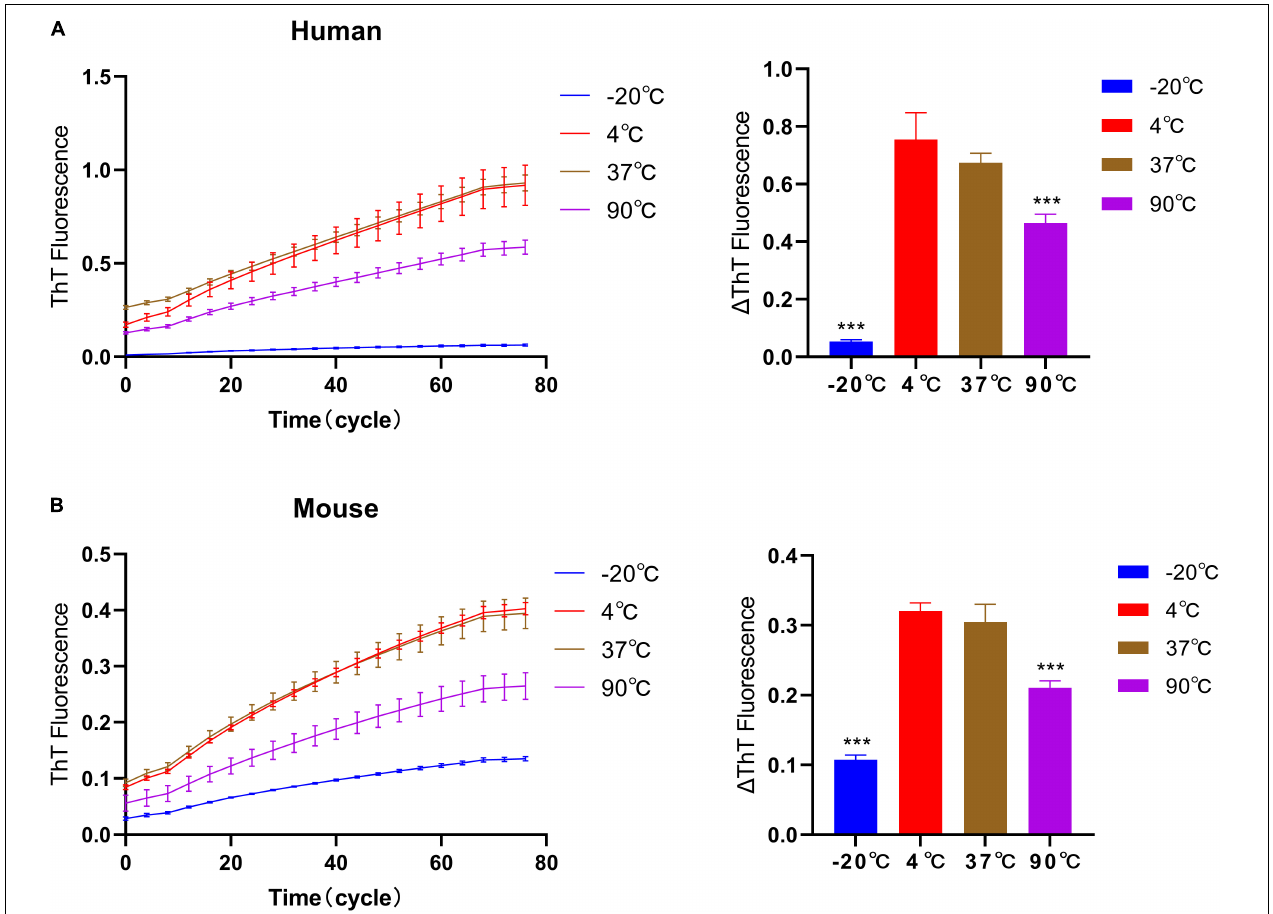
FIGURE 5 | Effect of temperature pretreatment of fibril seeds on quiescent incubation curve. The human and mouse fibril seeds were pre-incubated under different temperature conditions (–20 ◦ C, 4 ◦ C, 37 ◦ C, and 90 ◦ C) for 2 h, then incubated with homologous monomers under 37 ◦ C. (A) The effect of temperature pretreatment of human seeds on the quiescent incubation curve, left. Corresponding (cid:49) ThT fluorescence value, right. (B) Effect of temperature pretreatment of mouse seeds on quiescent incubation curves, left. Corresponding (cid:49) ThT fluorescence value, right. Human and mouse α -synuclein fibril seeds still have the self-recruitment ability even after treatment at 90 ◦ C. After being treated at –20 ◦ C, the self-recruitment ability decreased significantly. All data are expressed in mean ± SD. Compared with the 37 ◦ C group, *** P <